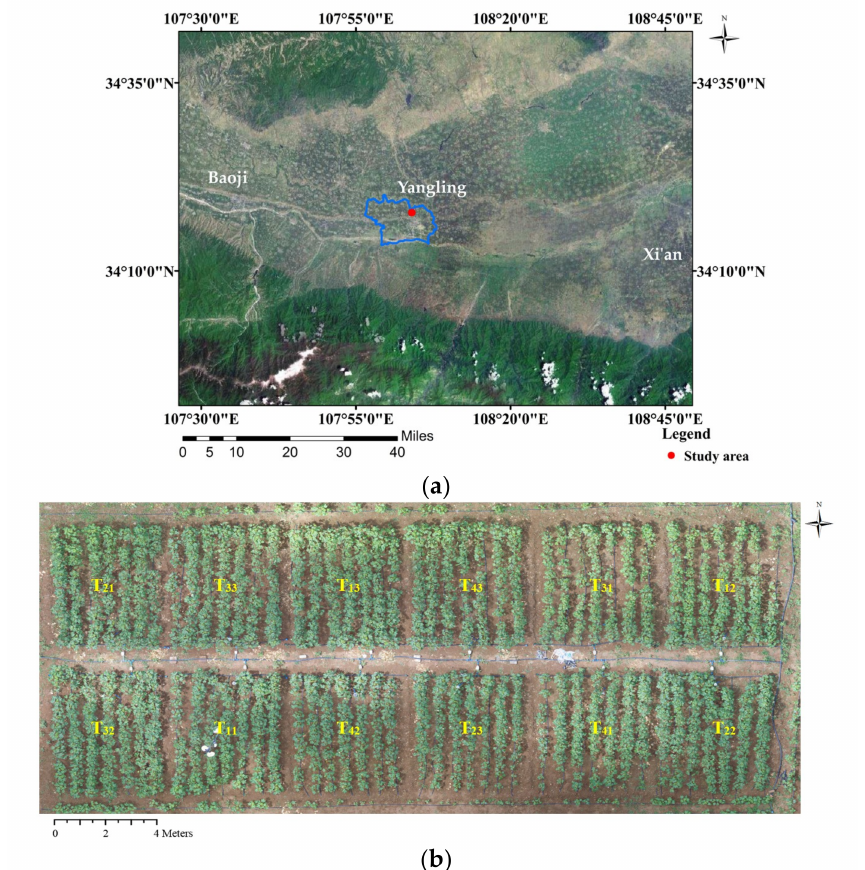
Figure 1. ( a ) Location of the experimental site from basemap of ArcGIS software; ( b ) RGB image of the study area. The labels indicate the treatment and the replicate. For example, T 11 represents the first replicate of the first